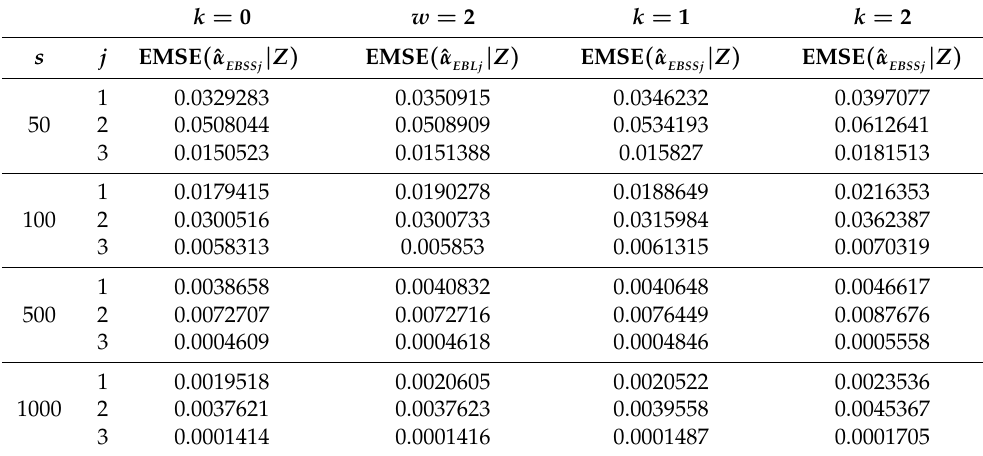
Table 13. Results of calculated EMSE of ˆ α for different s with u = 3 and v = 4 using the data set.